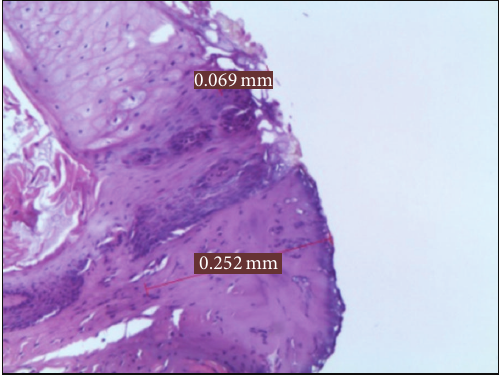
Figure 2: Histological specimen B 4 , using 3 watt in CW, colour EE, magnification from original 40x.